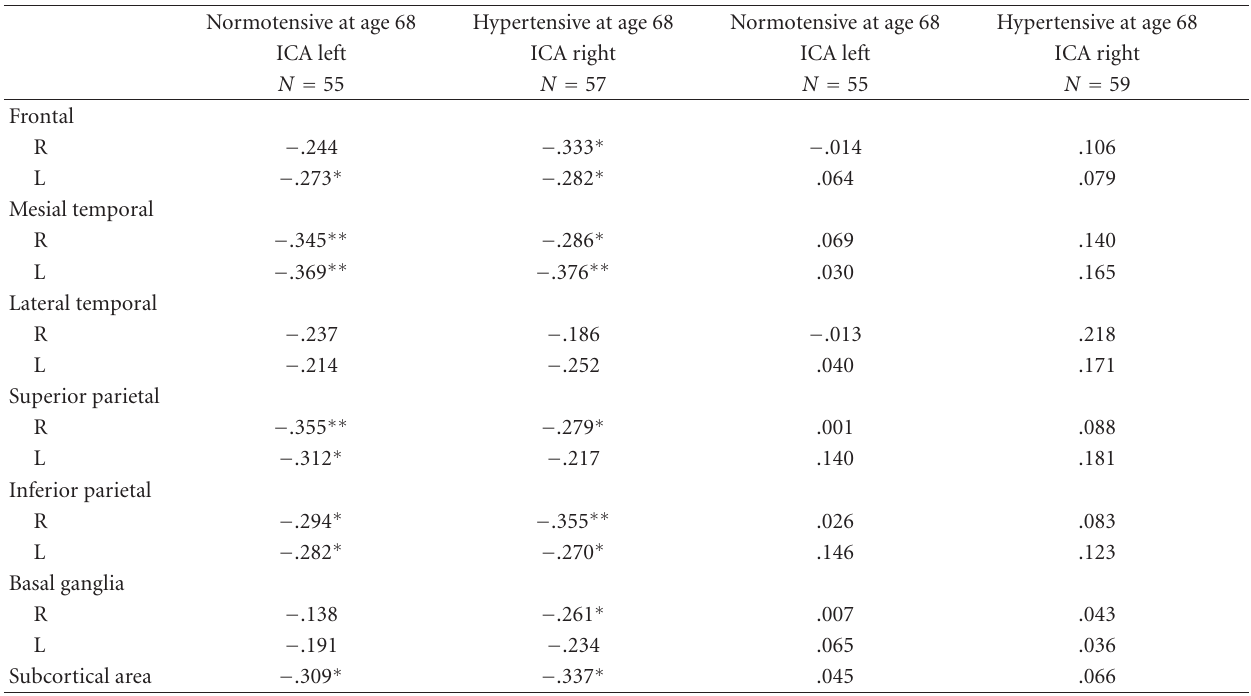
Table 2: Correlation coe ffi cients between peak systolic velocity in right/left ICA and cerebral blood flow estimated in several regions of interest. Analyses performed in study subjects defined as normotensive and hypertensive at age